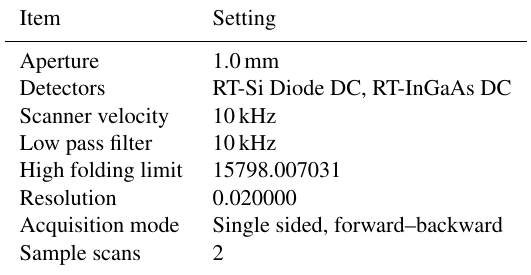
Table 1. Measurement settings for the Sodankylä Bruker 125HR FTS